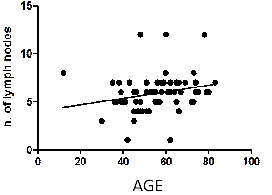
Correlation between the size of the largest lymph node and age. Spearman r 0.3172; 95% confidence interval 0.1440 to 0.4715; P value (two-tailed) 0.0003; P value summary ***.